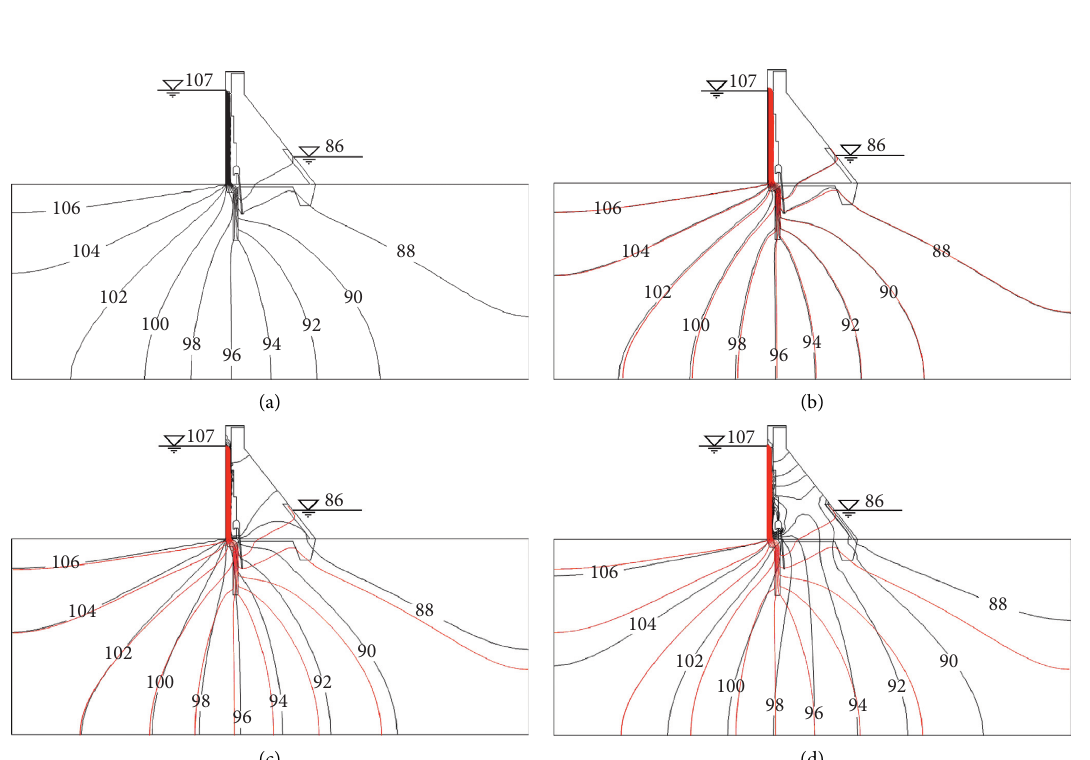
Figure 13: Evolution of the total water head distribution along the dam baseline (unit, (m)); the leaching duration is from 1a to 100a. (a) 0a. (b) 10 a. (c) 50a. (d)